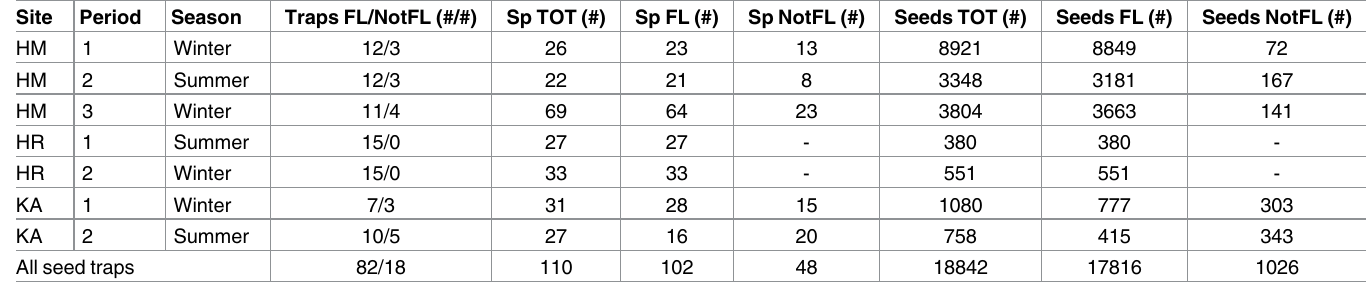
Table 1. Overview of the number of species and number of seeds deposited in seed traps per researchsite, period of monitoring and season. Site